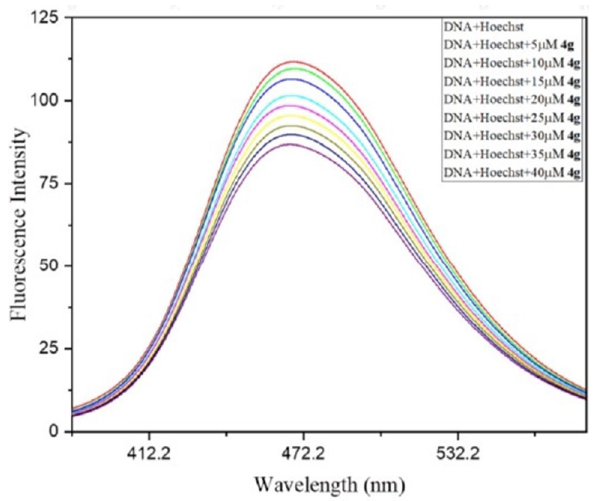
Figure 13. Competitive displacement plot of DNA–Hoechst complex in the absence and presence of varying amount of 4g (0–40